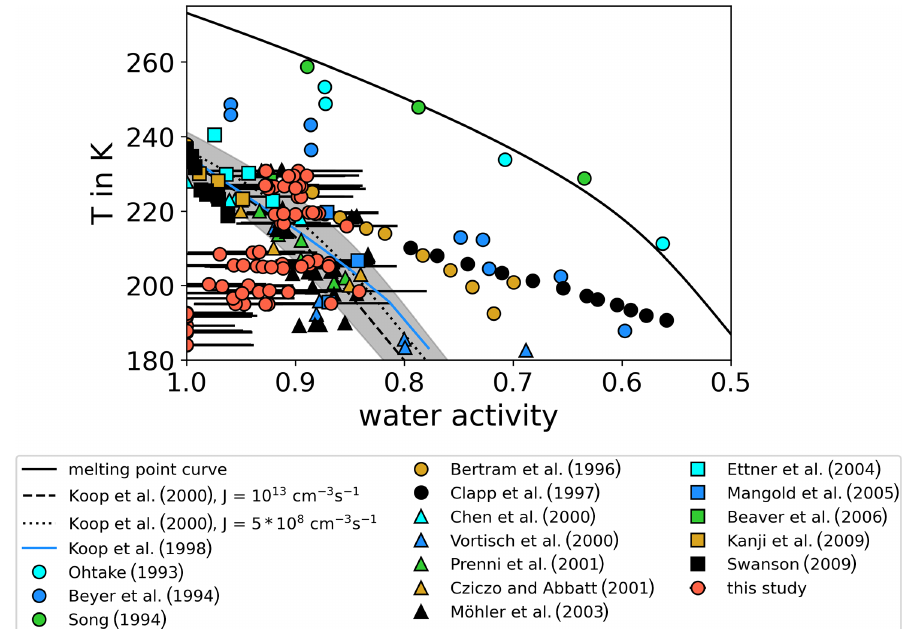
Figure C1. Summary of homogeneous freezing measurements of H 2 SO 4 / H 2 O solutions in the a w – T space. The homogeneous freezing onsets of sulfuric acid solution samples shown in Fig. 1 are complemented by the AIDA results from this study (red points). The results in the S ice – T space were converted into the a w – T space by assuming equilibrium conditions a w = RH w and by using the parameterizations for the water vapor saturation pressures with respect to ice and supercooled liquid water given by Murphy and Koop (2005). The uncertainties of the calculated a w values vary between ± 0.036 and ±